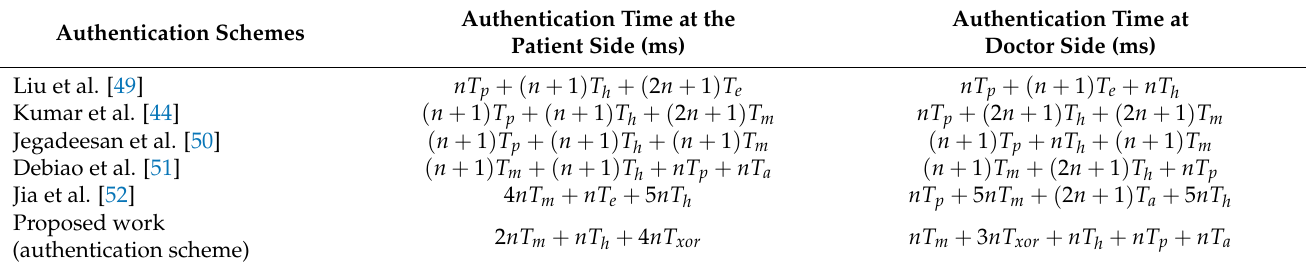
Table 2. Relations for calculation of computational time for analyzed authentication schemes.